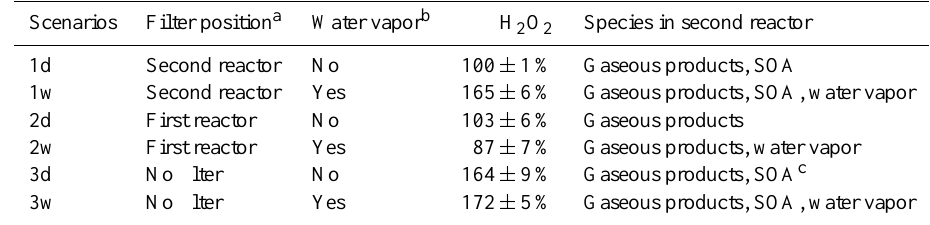
Table 3. Hydrogen peroxide in the coil collector at different scenarios in the two-stage experiments.